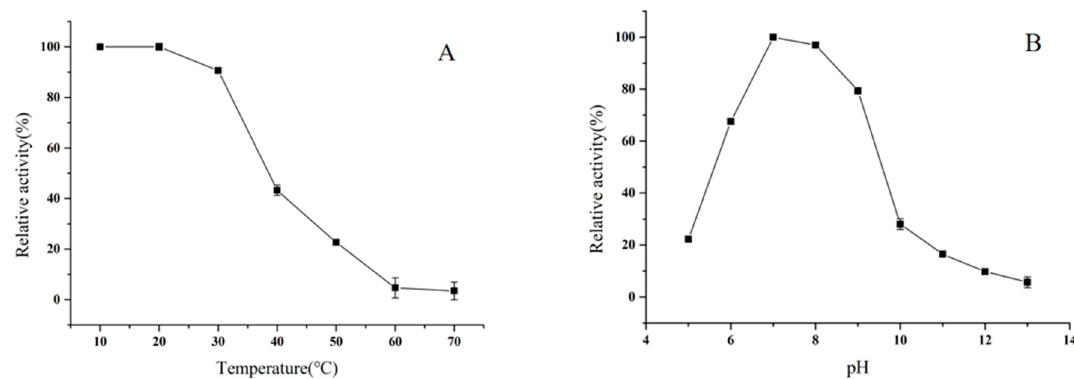
Figure 8. Effects of temperature ( A ) and pH ( B ) on BpTA-2 stability. Maximum activity in A (3.62 ± 0.19 U/mg) and B (3.30 ± 0.17 U/mg) was set as 100% and relative activity was calculated by comparison with the maximal activity.